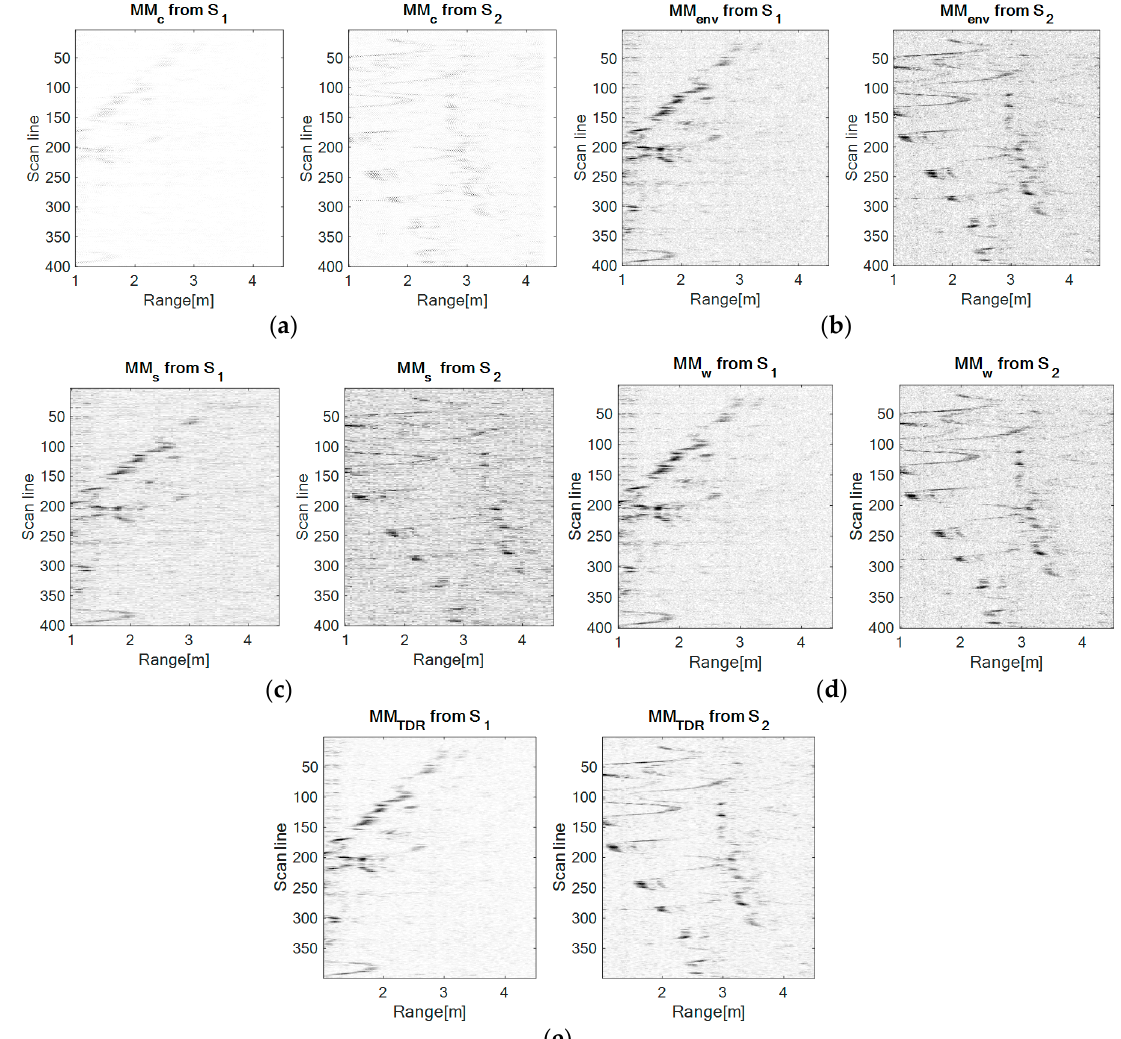
Figure 9. The movement maps for the left-right configuration obtained with each method: ( a ) The correlation method, ( b ) the envelope detection method, ( c ) the spectrogram method: Window size: 64, number of overlapped samples: 60, number of FFT points: 128, ( d ) the wavelet transform method: Mother Morlet wavelet, ( e ) the TDR RPA method: m = 5, d = 1.